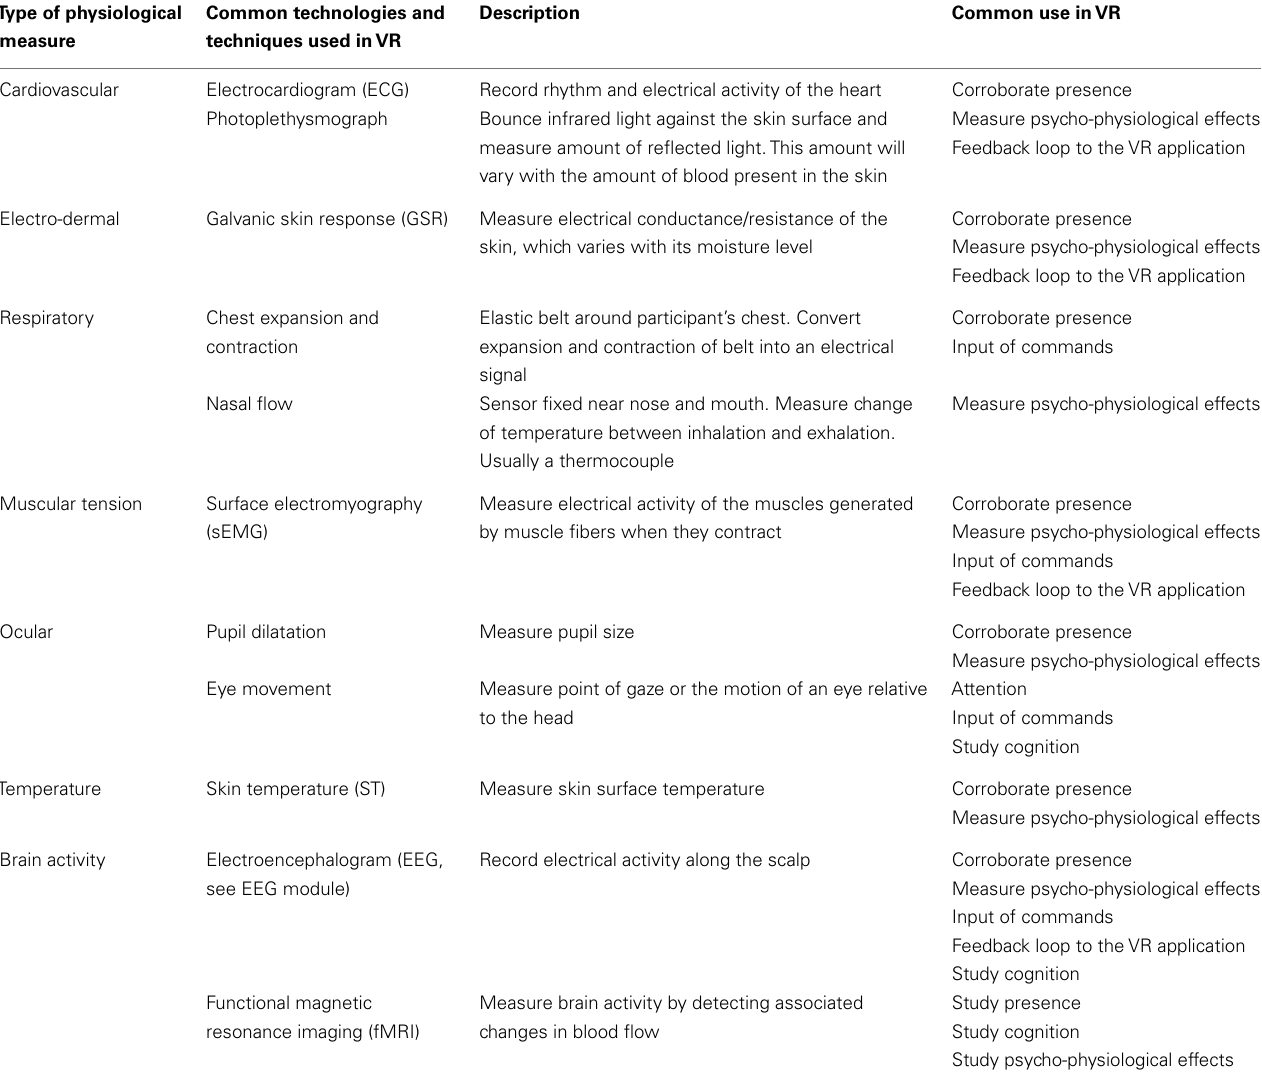
Table 5 | Summary of physiological measures, technologies, and their common use inVR